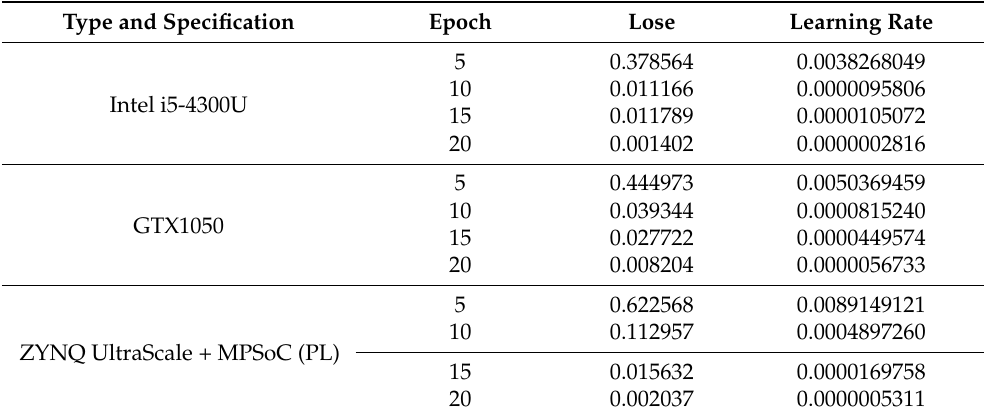
Table 5. Training process parameters for different.